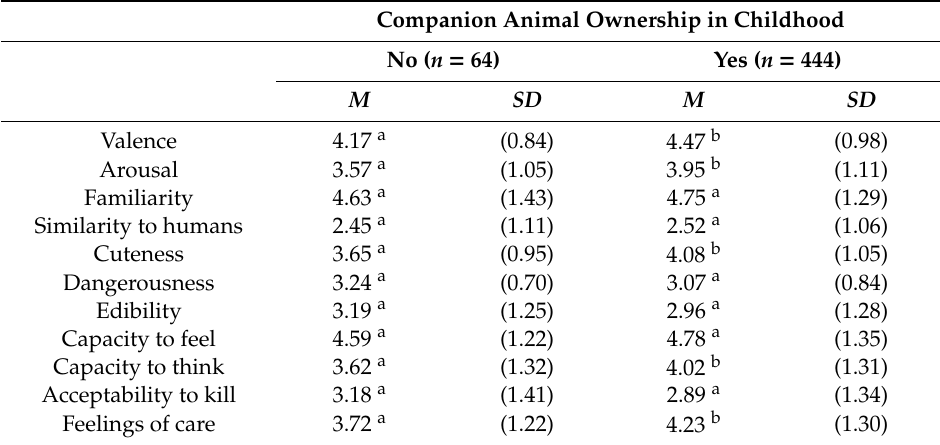
Table 6. Mean scores for evaluative dimensions by companion animal ownership in